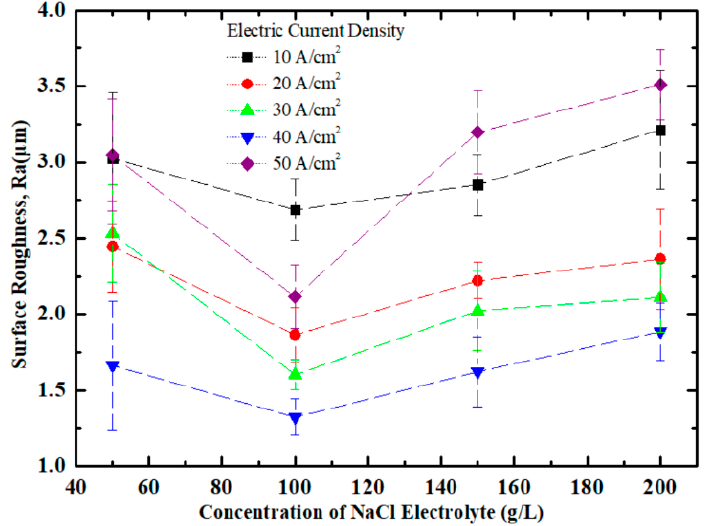
Figure 4. Surface roughness of workpiece at different concentration in NaCl electrolyte.